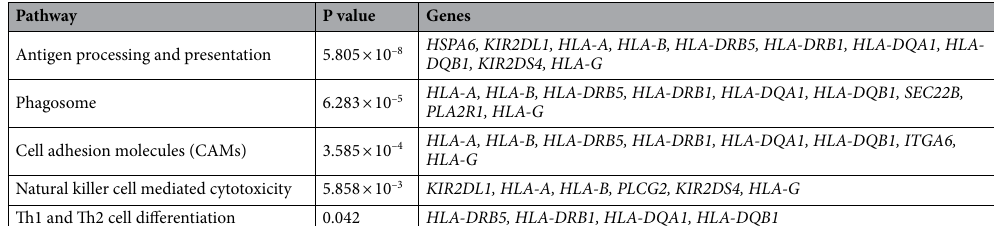
Table 3. Kyoto Encyclopedia of Genes and Genomes (KEGG) pathway analysis and candidate genes. P values were from Kyoto Encyclopedia of Genes and Genomes (KEGG) pathway analysis and P values were adjusted by Benjamini–Hochberg false discovery rate.